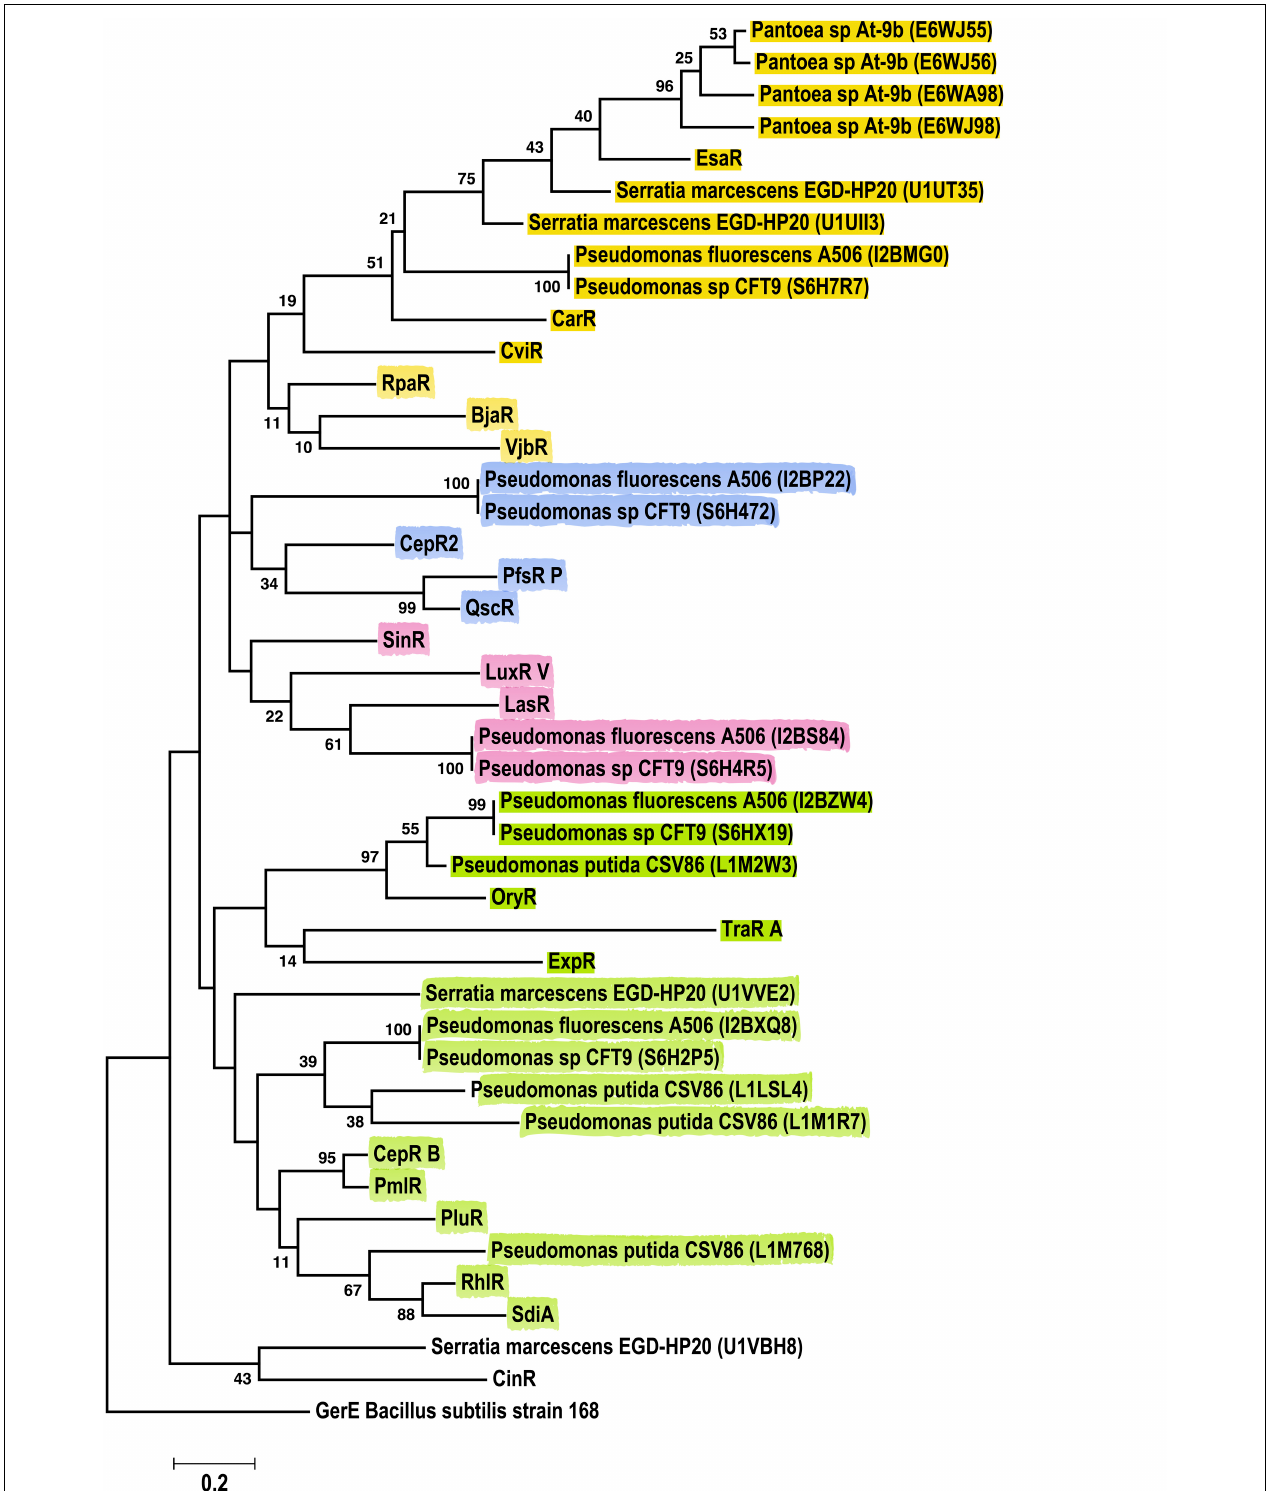
FIGURE 7 | Phylogenetic analyses of multiple LuxR solos carried by the Gammaproteobacteria. The tree was inferred by using the Maximum Likelihoodmethod.Treeisdrawntoscale,withbranchlengthsmeasuredinthe number of substitutions per site. The analysis involved 44 amino acid